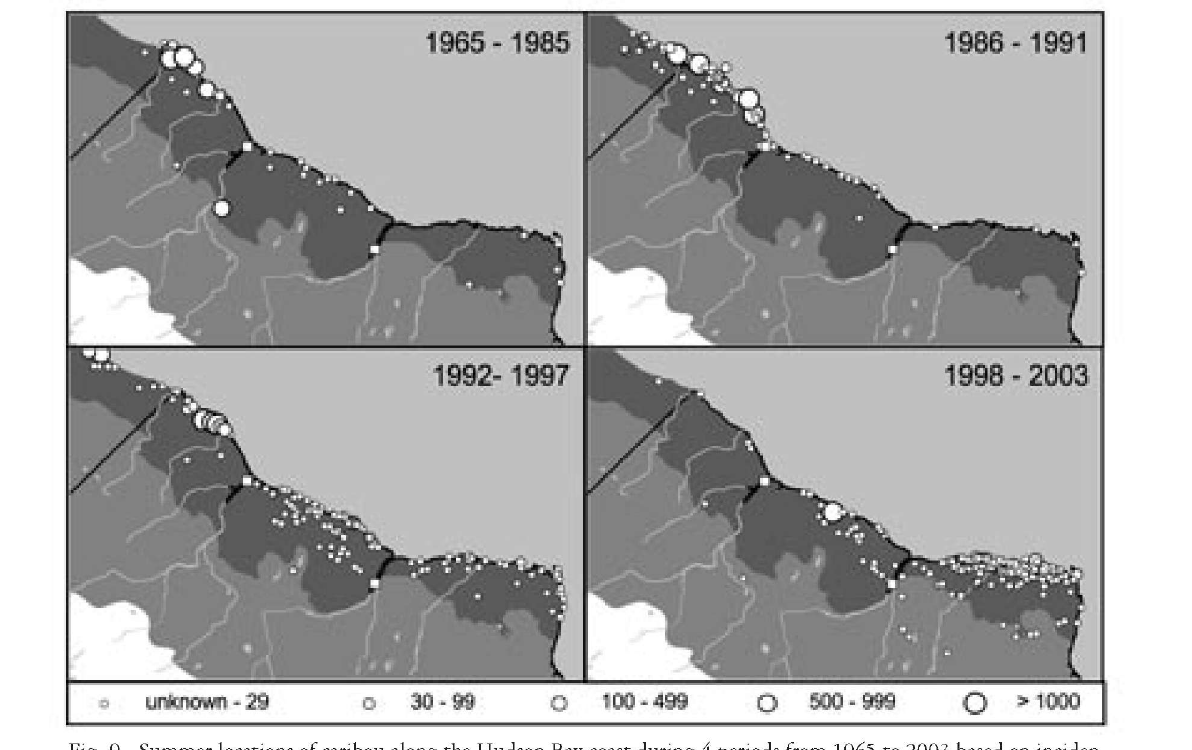
Fig. 9. Summer locations of caribou along the Hudson Bay coast during 4 periods from 1965 to 2003 based on inciden tal observations and photographic surveys.